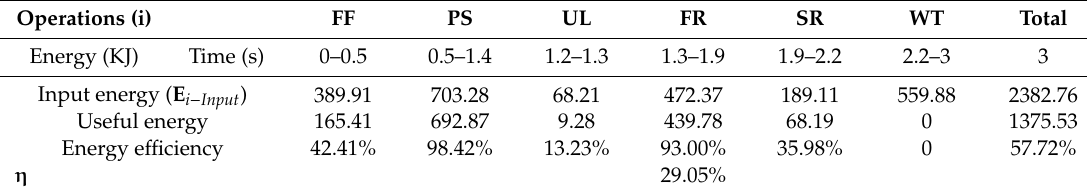
Table 5. Energy dissipation of each operation in the hydraulic press with PFS (Constant Forging).